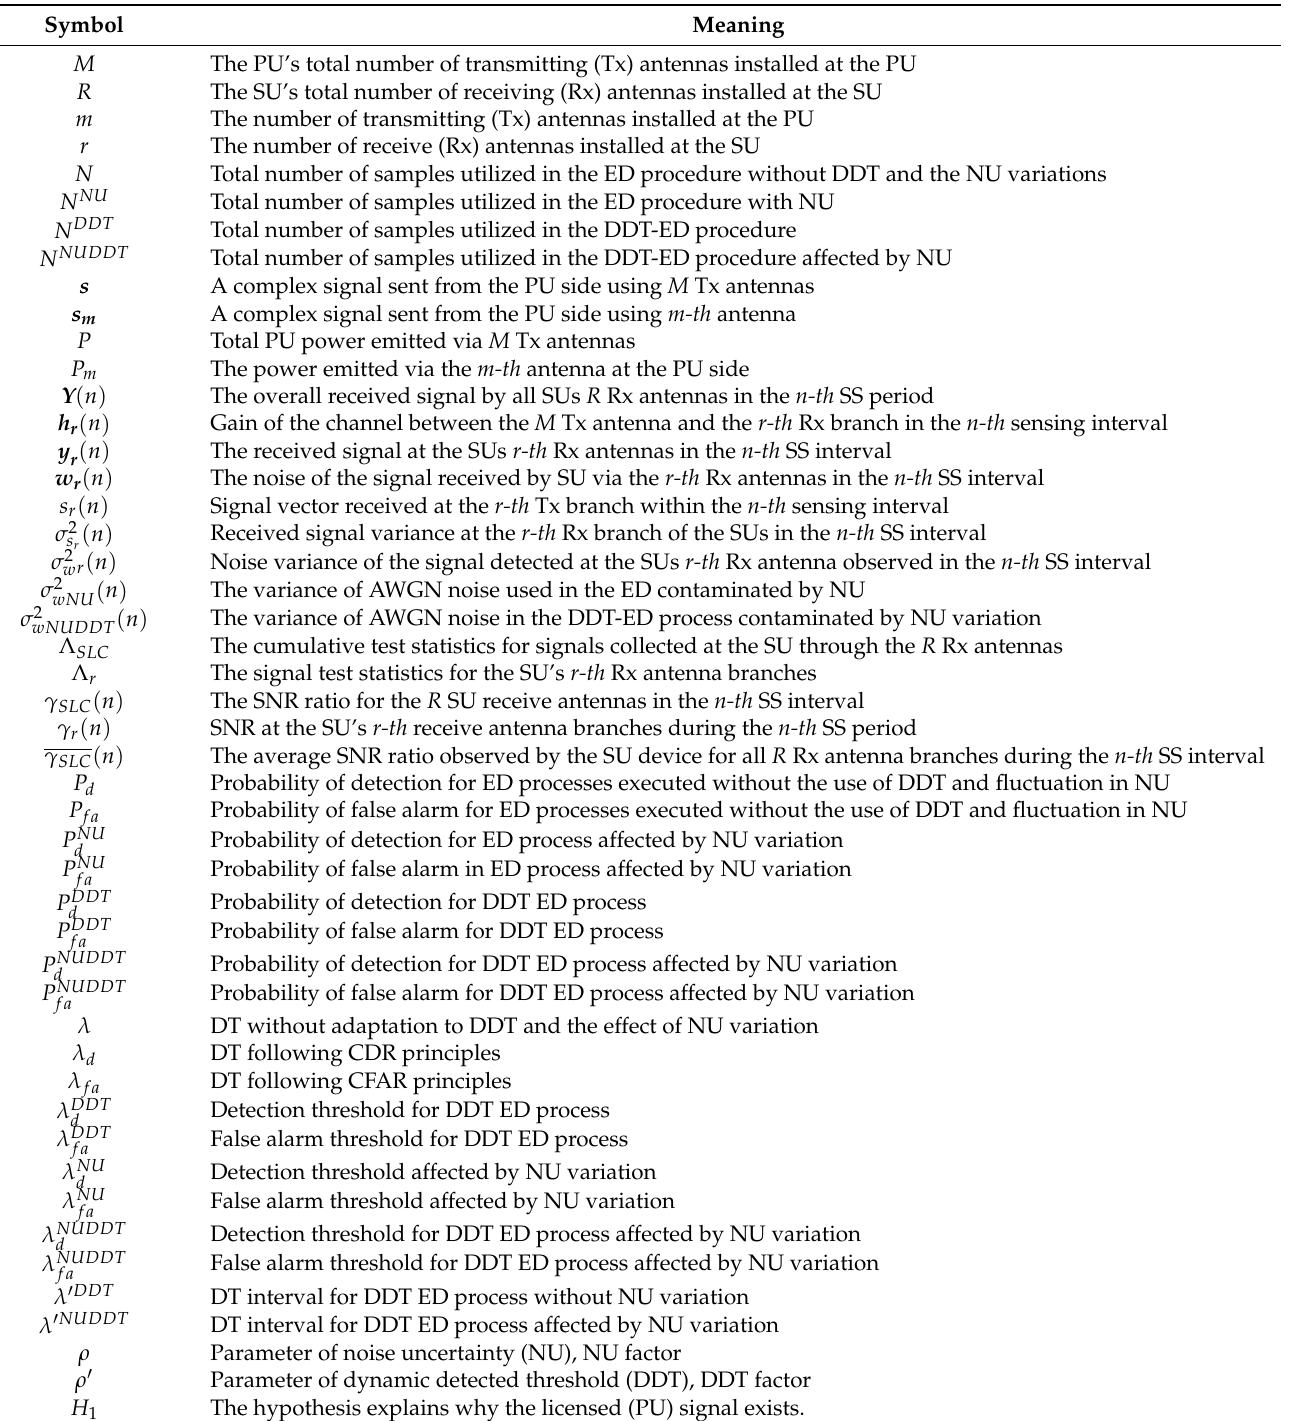
Table 1. Parameters used to analyse the ED